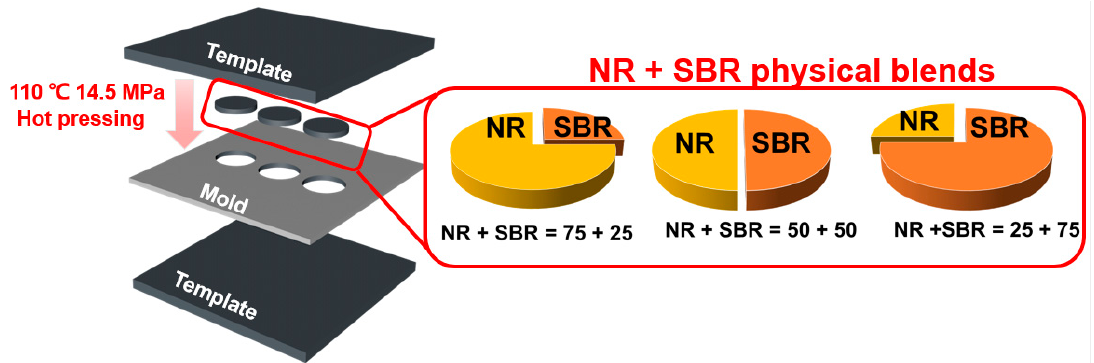
Figure 1. Preparation scheme of NR + SBR physical blends with different weight ratios for rheological measurements. Here, NR and SBR disks with a thickness of 2 mm and a diameter of 25 mm were cut and combined laterally at different weight ratios, and then hot-pressed without internal mixing. The gold and orange parts represent NR and SBR,